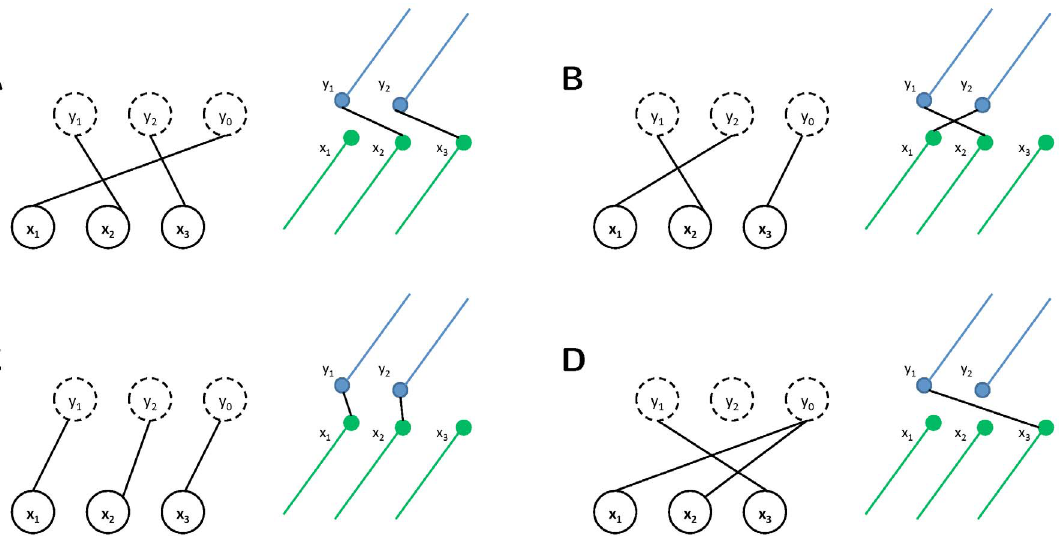
Figure 6. Examples of matching configurations. Centerlines from two consecutive sections are depicted in blue and green. The random variables x 1 , x 2 , x 3 are illustrated on the left of each panel. Connections to y 1 and y 2 indicate assignments to endpoints in the neighboring section. Connections to y 0 indicate assignments to the placeholder. A and C: consistent assignments. C should be preferred because the corresponding points are closer. B and D: assignments that should be